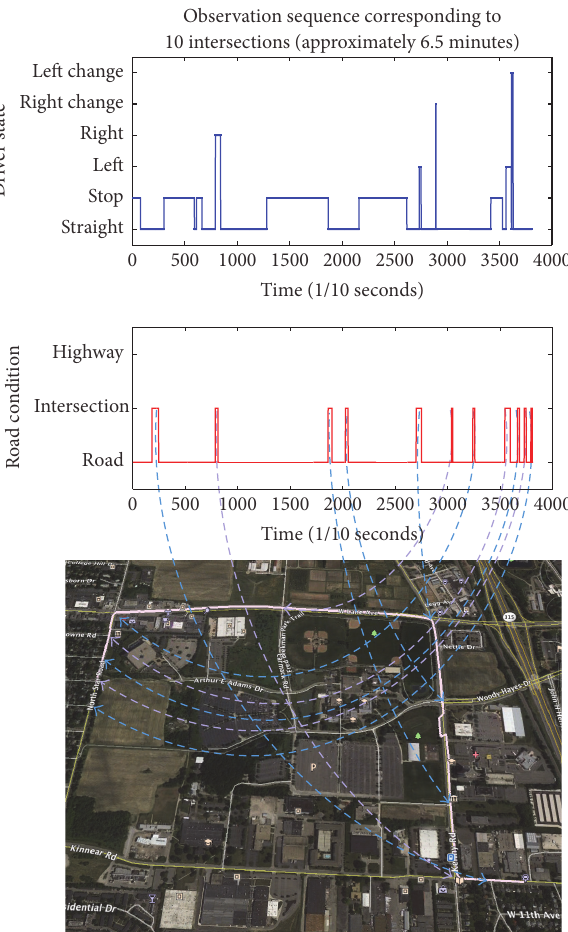
Figure 9: Example of driver behavior estimation using metastate modification. Blue and purple arrows highlight areas where the road condition